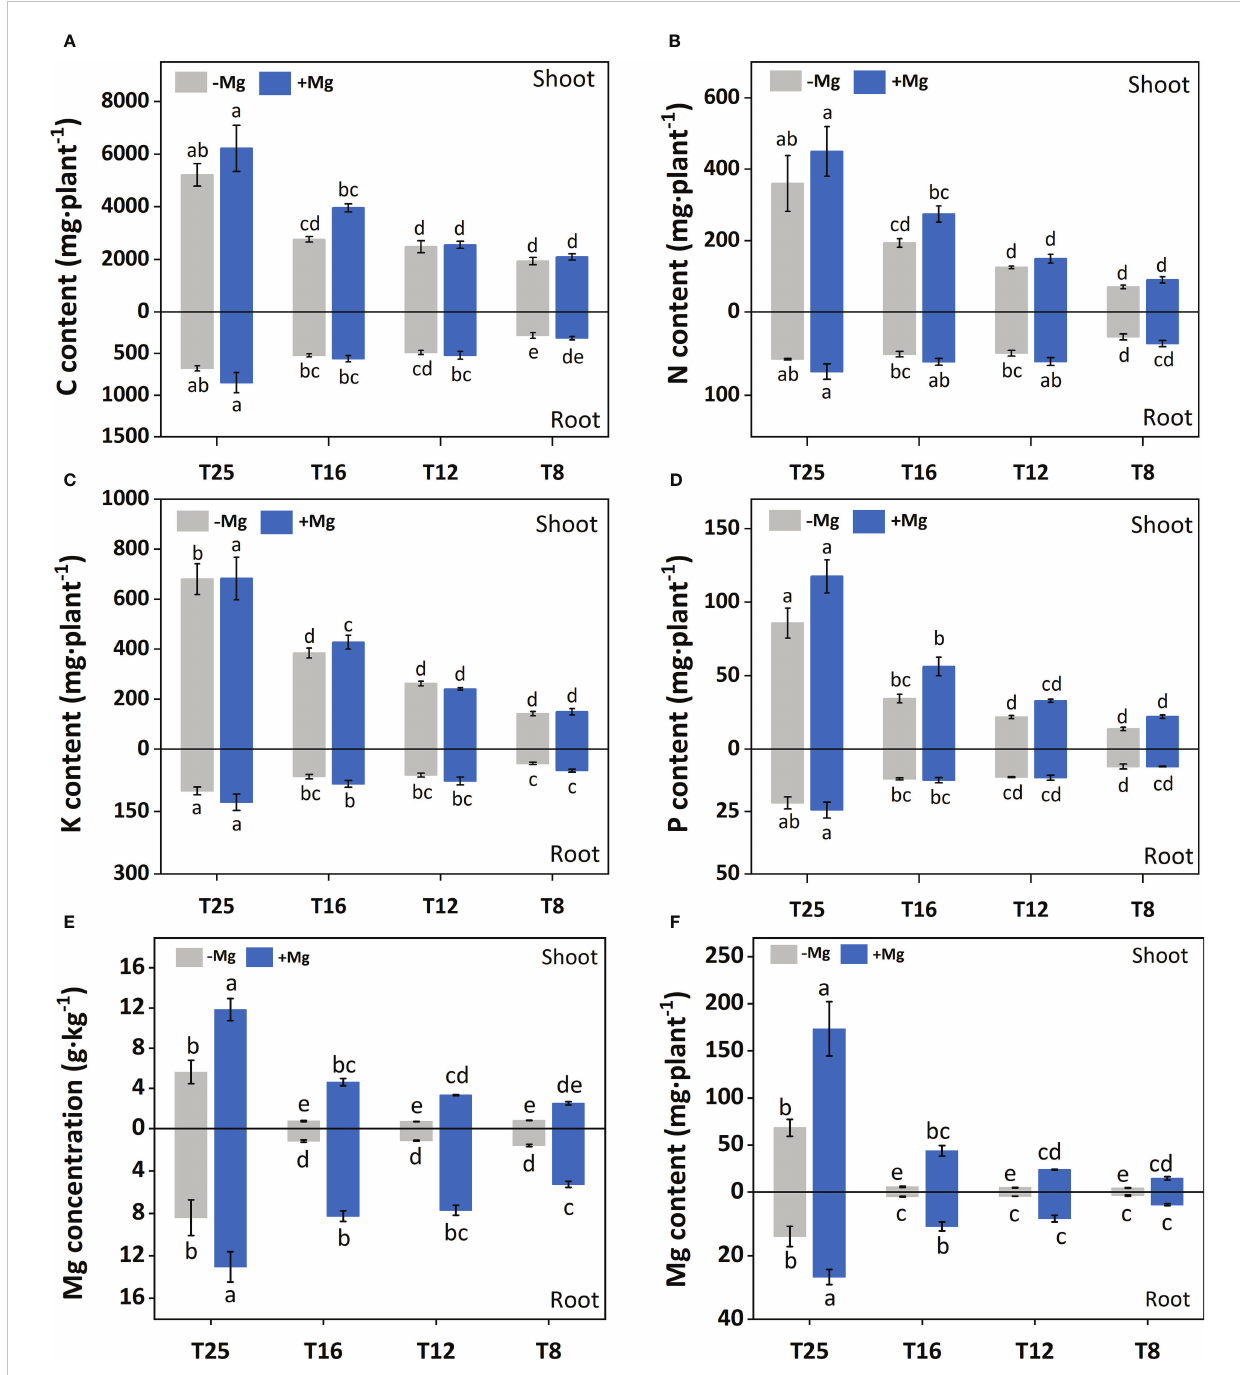
FIGURE 3 Effect of Mg application on concentration of minerals nutrients under different temperature in tobacco plant. (A) shoot-C content and root-C content; (B) shoot-N content and root-N content; (C) shoot-K content and root-K content; (D) shoot-P content and root-P content; (E) shoot-Mg concentration and root-Mg concentration; (F) shoot-Mg content and root-Mg content. The different letters above the bars are indicating signi fi cant difference (Duncan P <